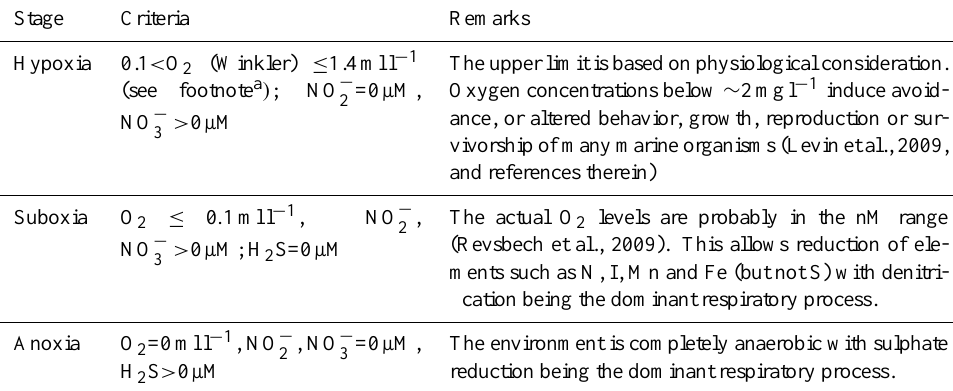
Table 1. Definitions of various stages of O 2